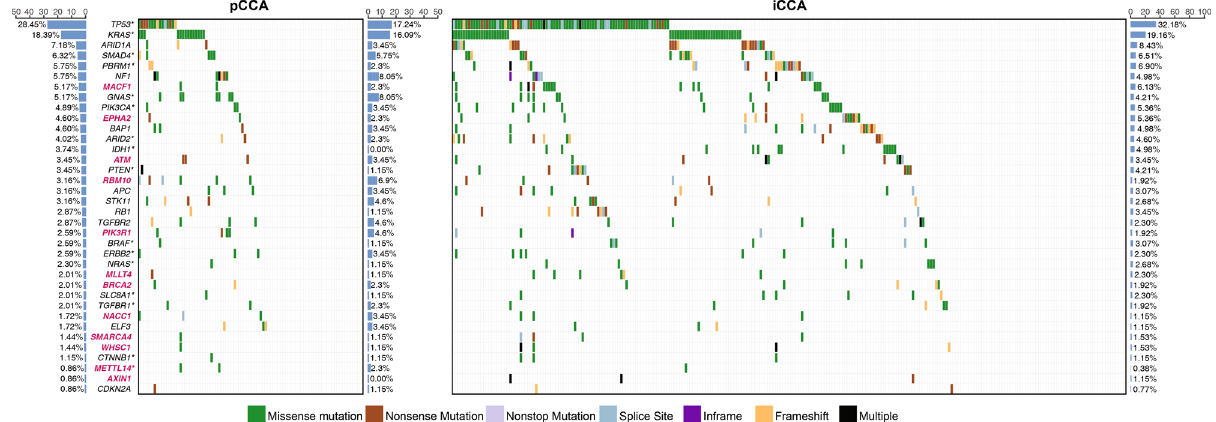
Fig. 2 Mutation landscapes of curated signi fi cantly mutated genes (SMGs) and recurrent mutation genes in CCA. Each column represents one CCA patient and each row represents a gene. The gene symbols in red are our newly identi fi ed CCA-related genes, and genes in black have been reported in CCA. The bar chart at the left panel indicates the overall mutational rate of curated genes in all CCAs. The right panel is the mutation spectrum and mutation rate for pCCAs and iCCAs, respectively. The asterisks following gene symbol indicate there are recurrent mutations in the relevant